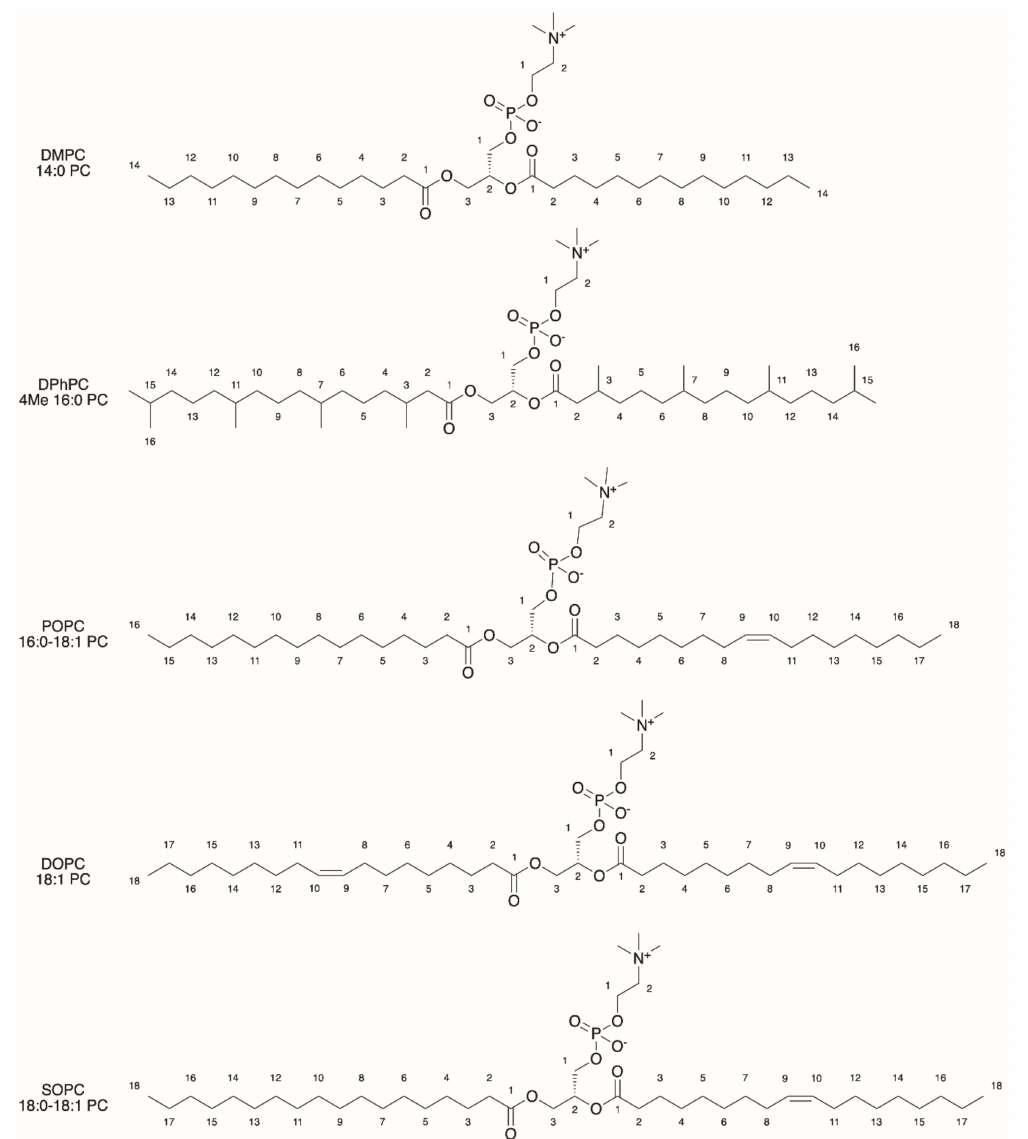
Figure 1. Structures of phosphatidylcholines that were used for the generation of liposomes with photosynthetic activity. Abbreviations are listed in the footnote of Table 1. Below the common abbreviation of the lipids, an alternative name is presented that describes the fatty acid chains in a comprehensible manner, i.e., (number of carbons in the fatty acid chain): (number of double bonds in the fatty acid chain). Thus, 14:0 corresponds to 14 carbons in the fatty acid chain without any double bond. In case of two different fatty acid chains, the individual descriptions of the chains are separated by a